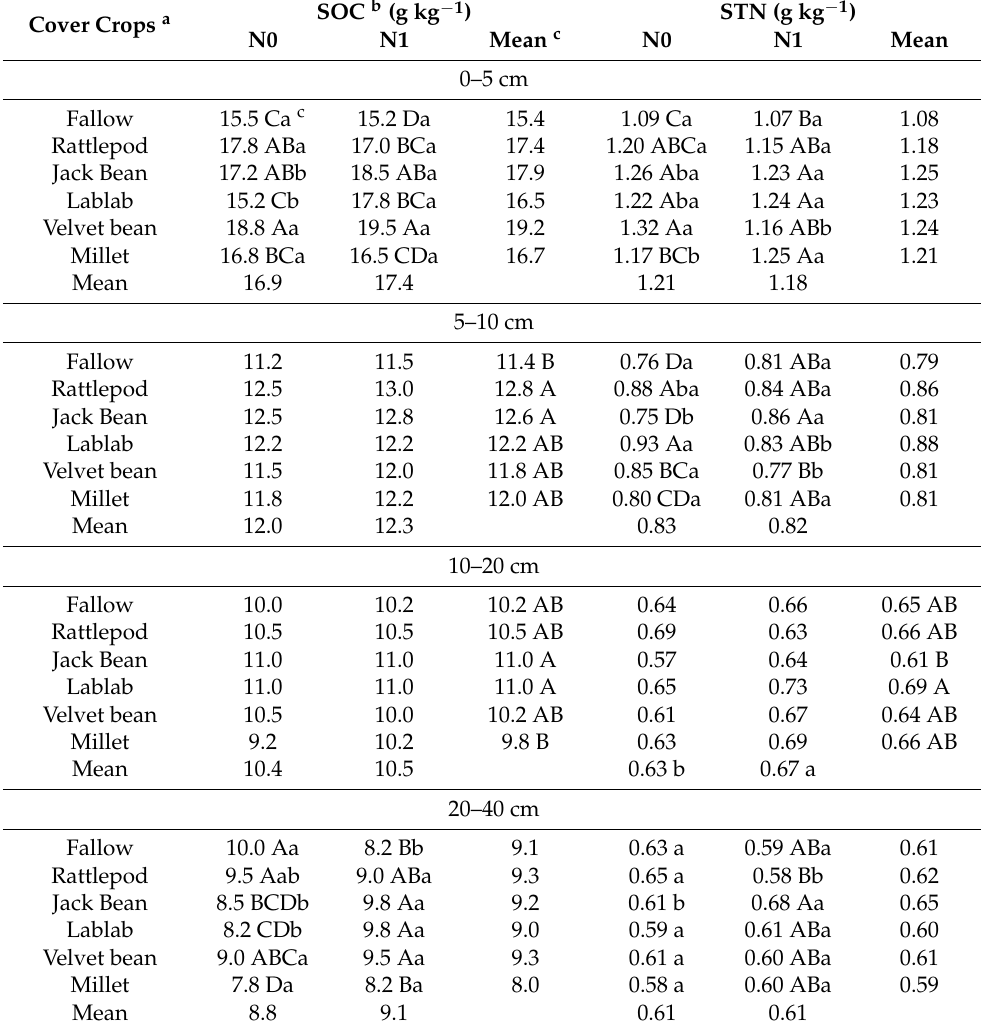
Table 3. Contents of soil organic carbon and nitrogen in samples collected from 0–5, 5–10, 10–20, and 20–40 cm soil layers as a function of cover crops grown before maize and nitrogen fertilizer doses. Cover Crops